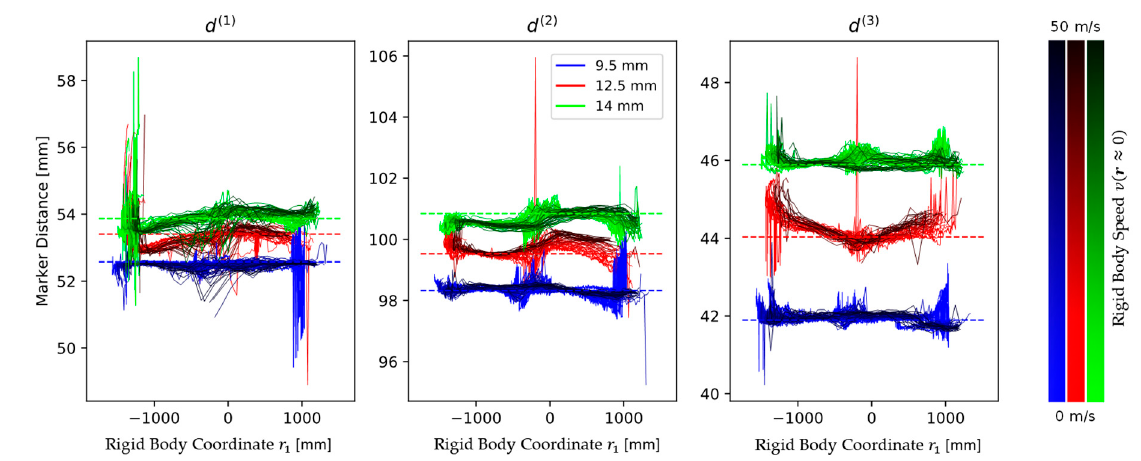
Figure 2. Marker distance as function of the rigid body coordinate 𝑟 (cid:2869) demonstrates the dependency of marker tracking accuracy on the position in 3D space. 𝒓 = 0 corresponds to the imaginary tee position. Mean rigid body speed is indicated by the darkness of the lines. Reference distances from static OMT measures, 𝑑 (cid:2899)(cid:2897)(cid:2904)((cid:2920)) added as dashed lines.